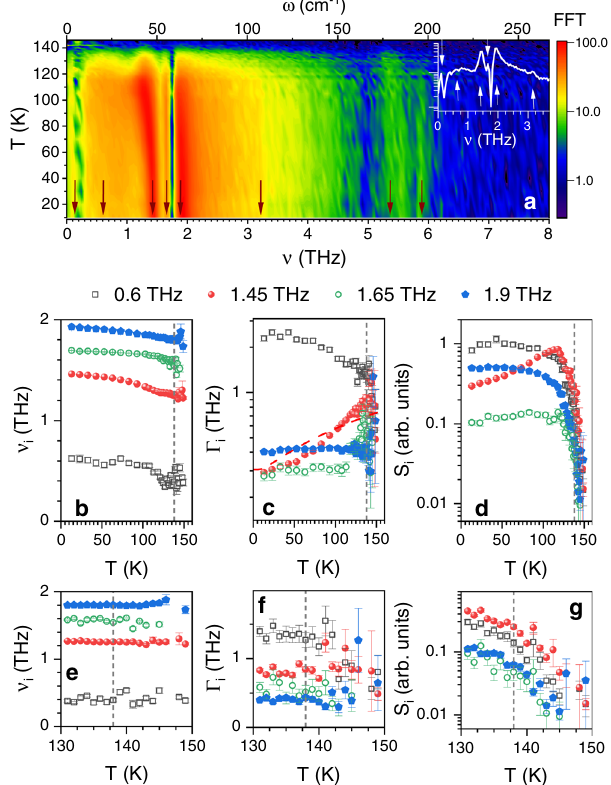
Fig. 2 Analysis of the oscillatory response. a Temperature dependence of the Fast Fourier Transform spectra, FFT, demonstrating the presence of several modes at low temperatures. The extracted mode frequencies, ν i in the low-temperature limit are denoted by red arrows (see also Supplementary Note 3). The top axis presents the energy scale in wavenumbers, ω (cm − 1 ). Insert presents the FFT of the data recorded at 13 K, with white arrows pointing at the modes. The temperature dependence of the parameters of the four strongest low-frequency modes, obtained by fi tting the oscillatory response with the sum of four damped oscillators: b central frequencies ν i , c linewidths Γ i , and d spectral weights S i . The triclinic phase transition temperature T S is denoted by vertical dashed lines. The dashed red line in c presents the expected T -dependence of the linewidth of 1.45 THz mode for the case, when damping is governed by the anharmonic phonon decay 33 . e – g present the zoom-in of the b – d , emphasizing the evolution of the parameters across the triclinic transition at T S = 138 K. The error bars are obtained from the standard deviation of the least-squared fi t.